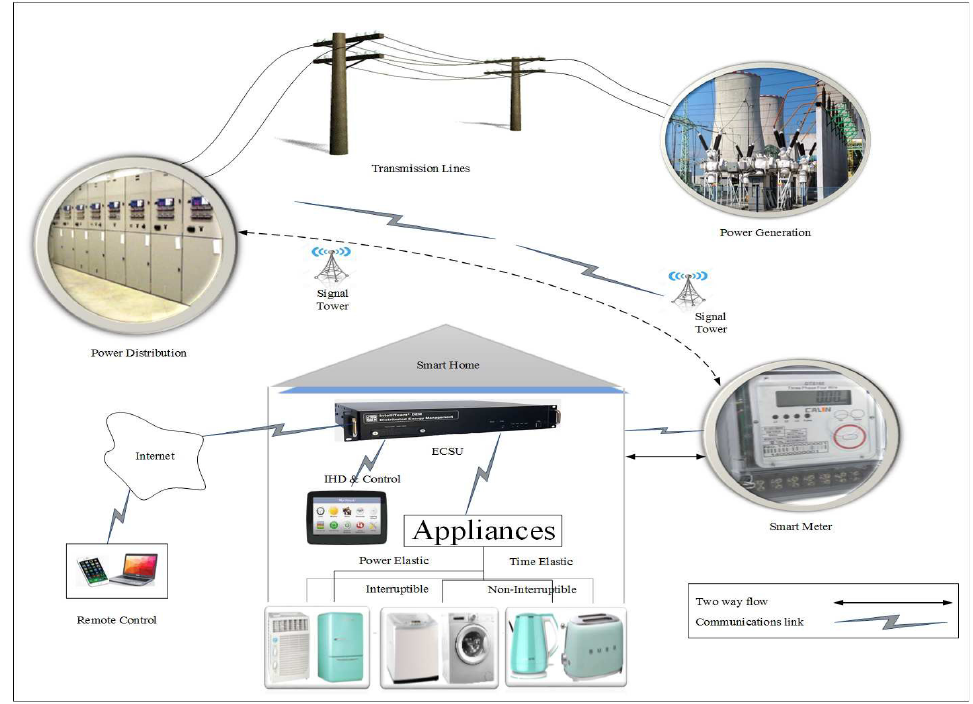
Figure 2. System architecture for ECSU including smart meter, remote control and IHD and